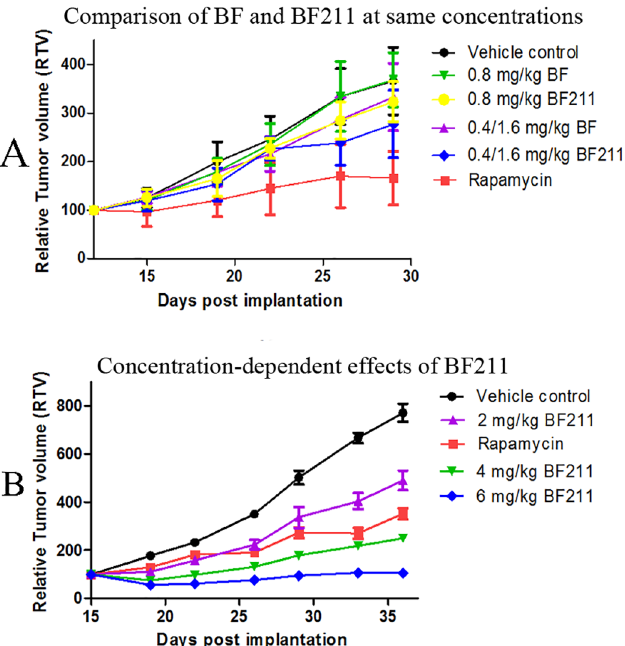
Fig 2. In vivo anti-cancer effects of BF and BF211 in nude mice inoculated with A549 cells. (A) The tumor growth curve of nude mice treated with vehicle control, rapamycin (positive control), BF or BF211 at similar concentrations as indicated. (B) The tumor growth curve of nude mice treated with vehicle control, rapamycin (positive control), and BF211 at concentrations of 2, 4, and 6